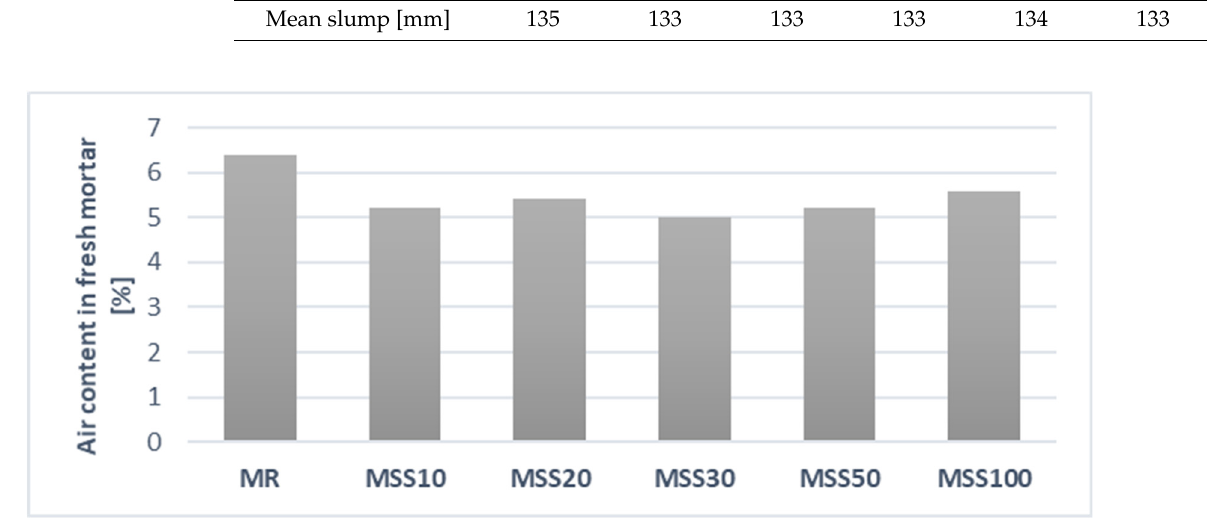
Figure 8. Air content in fresh mortar.